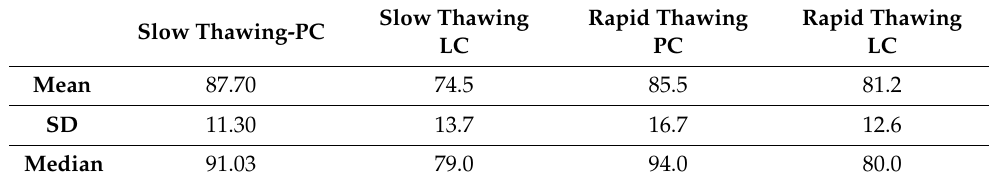
Table 1. Immediate post-thaw cell viability in